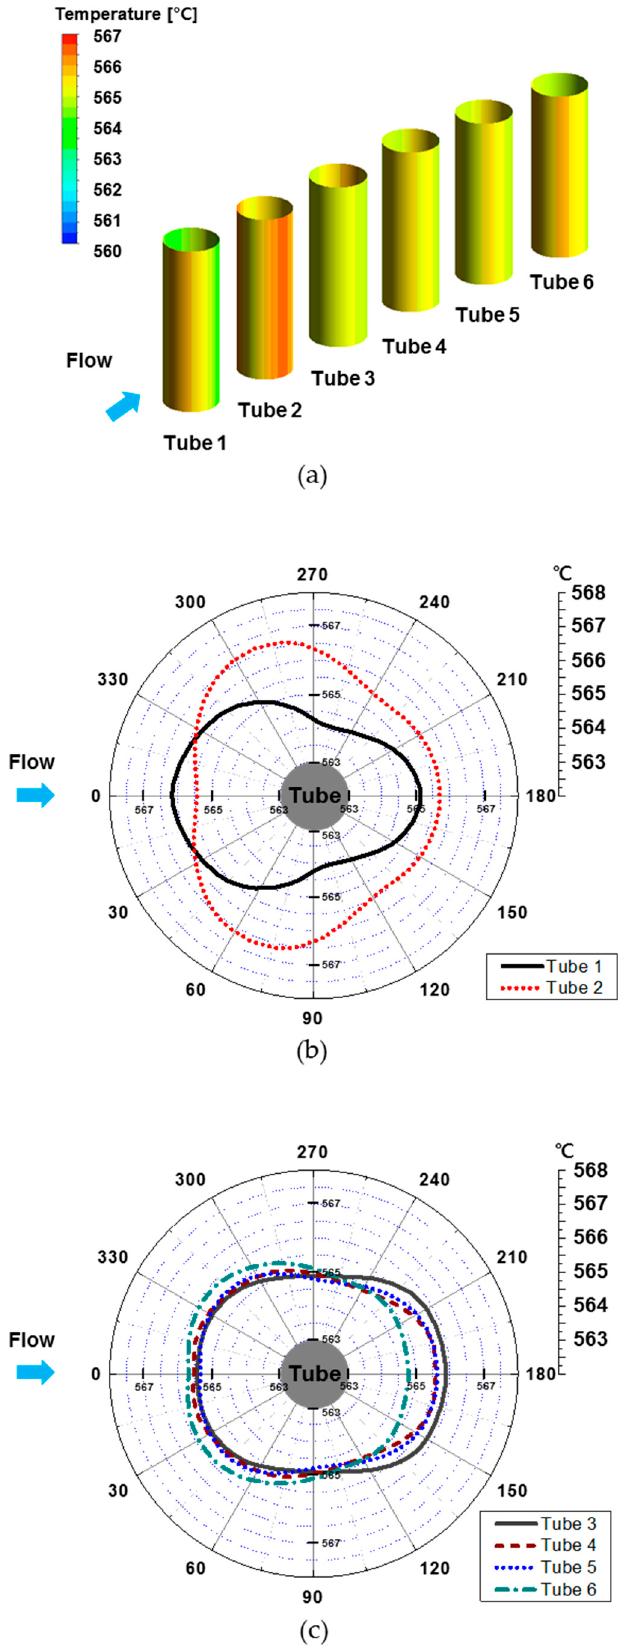
Figure 8. ( a ) Temperature distribution of tube bundles for Re = 30,000, Vertically averaged temperature distribution; ( b ) Tubes 1 and 2; ( c ) Tubes 3–6.